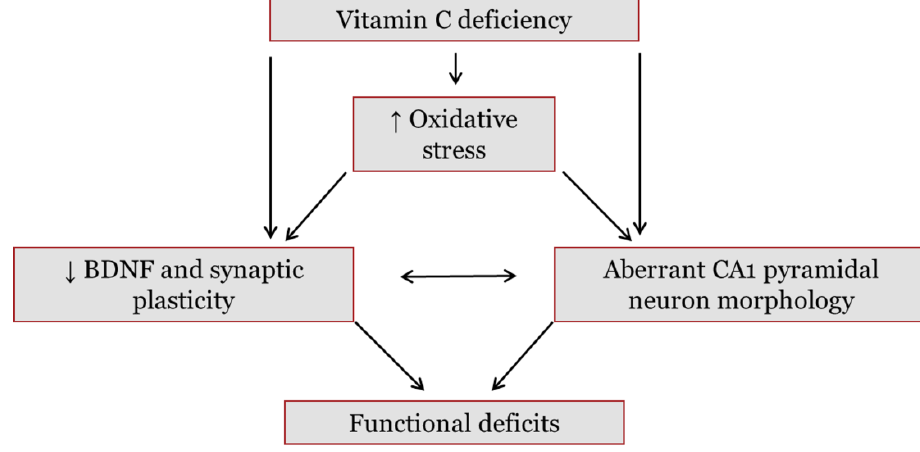
Figure 1. Hypothesized pathways through which vitamin C (vitC) deficiency may cause functional deficits in the brain. Reduced levels of vitC during deficiency may disturb redox balance and subsequently promote oxidative stress in the brain. In addition, vitC deficiency may exert a direct effect on brain function. Both vitC deficiency and increases in oxidative stress have been found to lower levels of brain-derived neurotrophic factor (BDNF) in the brain. A decrease in BDNF, and subsequent negative effects on downstream pathways, may reduce synaptic plasticity. Synaptic plasticity is crucial in memory formation and cognitive functions; hence, dysfunction may lower signal transmission and induce functional deficits. BDNF is also involved in neuronal arbor growth and a reduction may further induce aberrant dendrite development of hippocampal cornu ammonis (CA) 1 pyramidal neurons. These neurons are crucial in memory functions and have been found to be susceptible to increased oxidative stress and states of malnutrition. Collectively, vitC deficiency is hypothesized to cause changes in synaptic plasticity and neuronal morphology, potentially disrupting brain functionality.